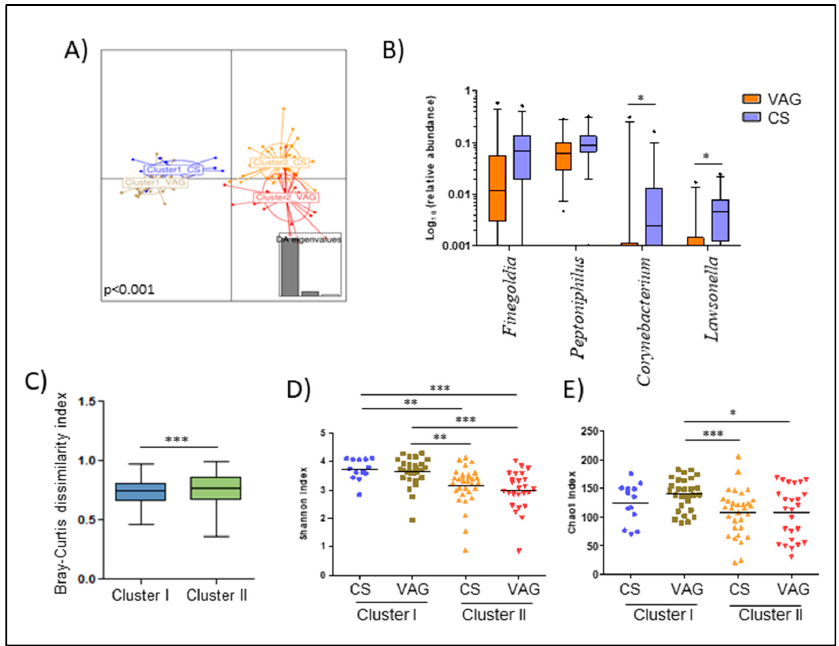
Figure 3. Maternal microbiota at delivery is dissentingly shaped by the delivery mode. ( A ) Discriminant analysis of principal components (DAPCs) of the maternal microbiota according to the variable that resulted from the combination of the cluster and delivery mode. ( B ) Boxplot of the main genera that marked the difference of the maternal microbiota composition between delivery modes in mothers classified as cluster II. Data was transformed by log10 of the relative abundance of each